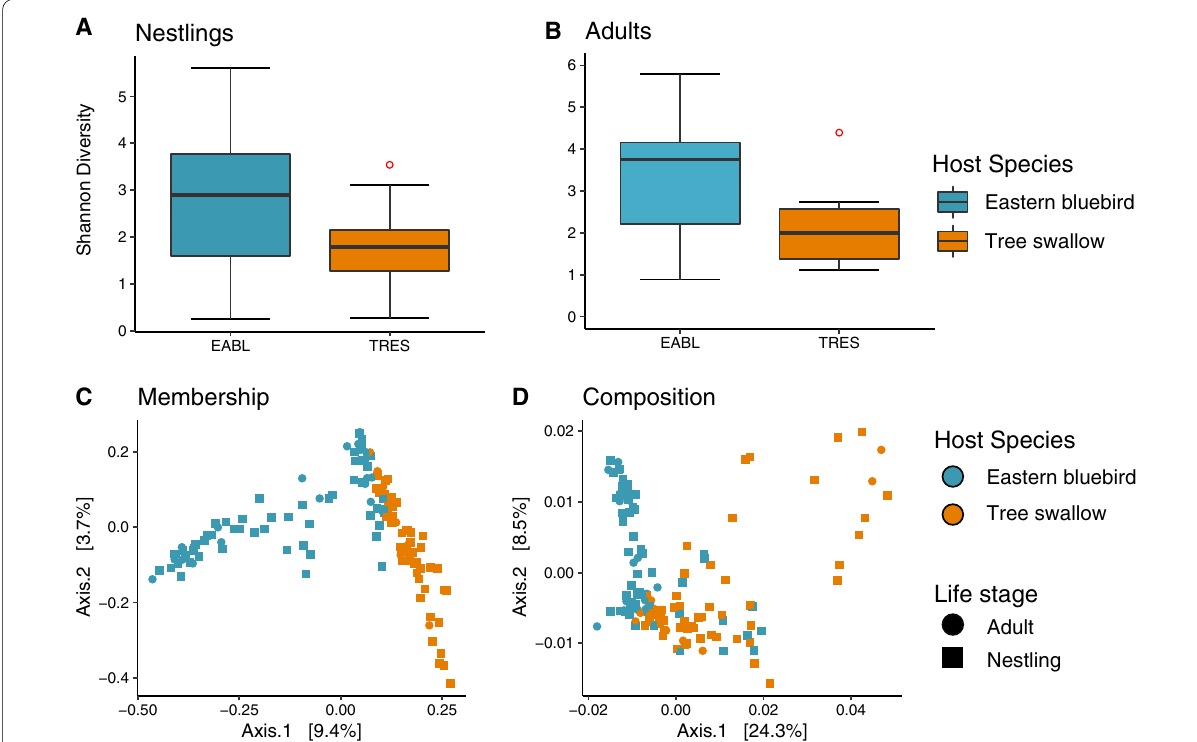
Fig. 3 Shannon diversity boxplots for nestlings ( a ) and adult birds ( b ) of both species. Midline represents the median Shannon diversity value. Red points indicate outliers. Principal coordinates ordination of ( c ) unweighted (membership) and ( d ) weighted (composition) UniF rac distances for all birds. Each point represents an individual sample colored according to host species. Point shape indicates host life